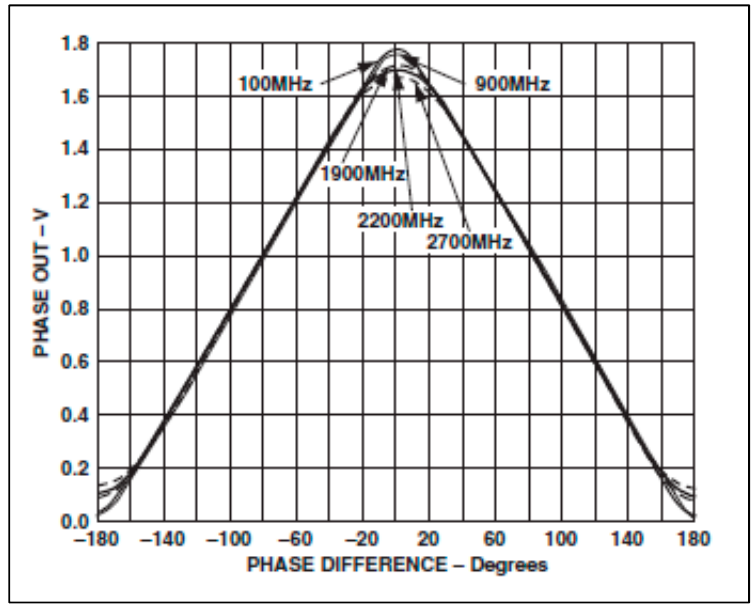
Figure 7. Phase Output vs. Input Phase Difference [23].